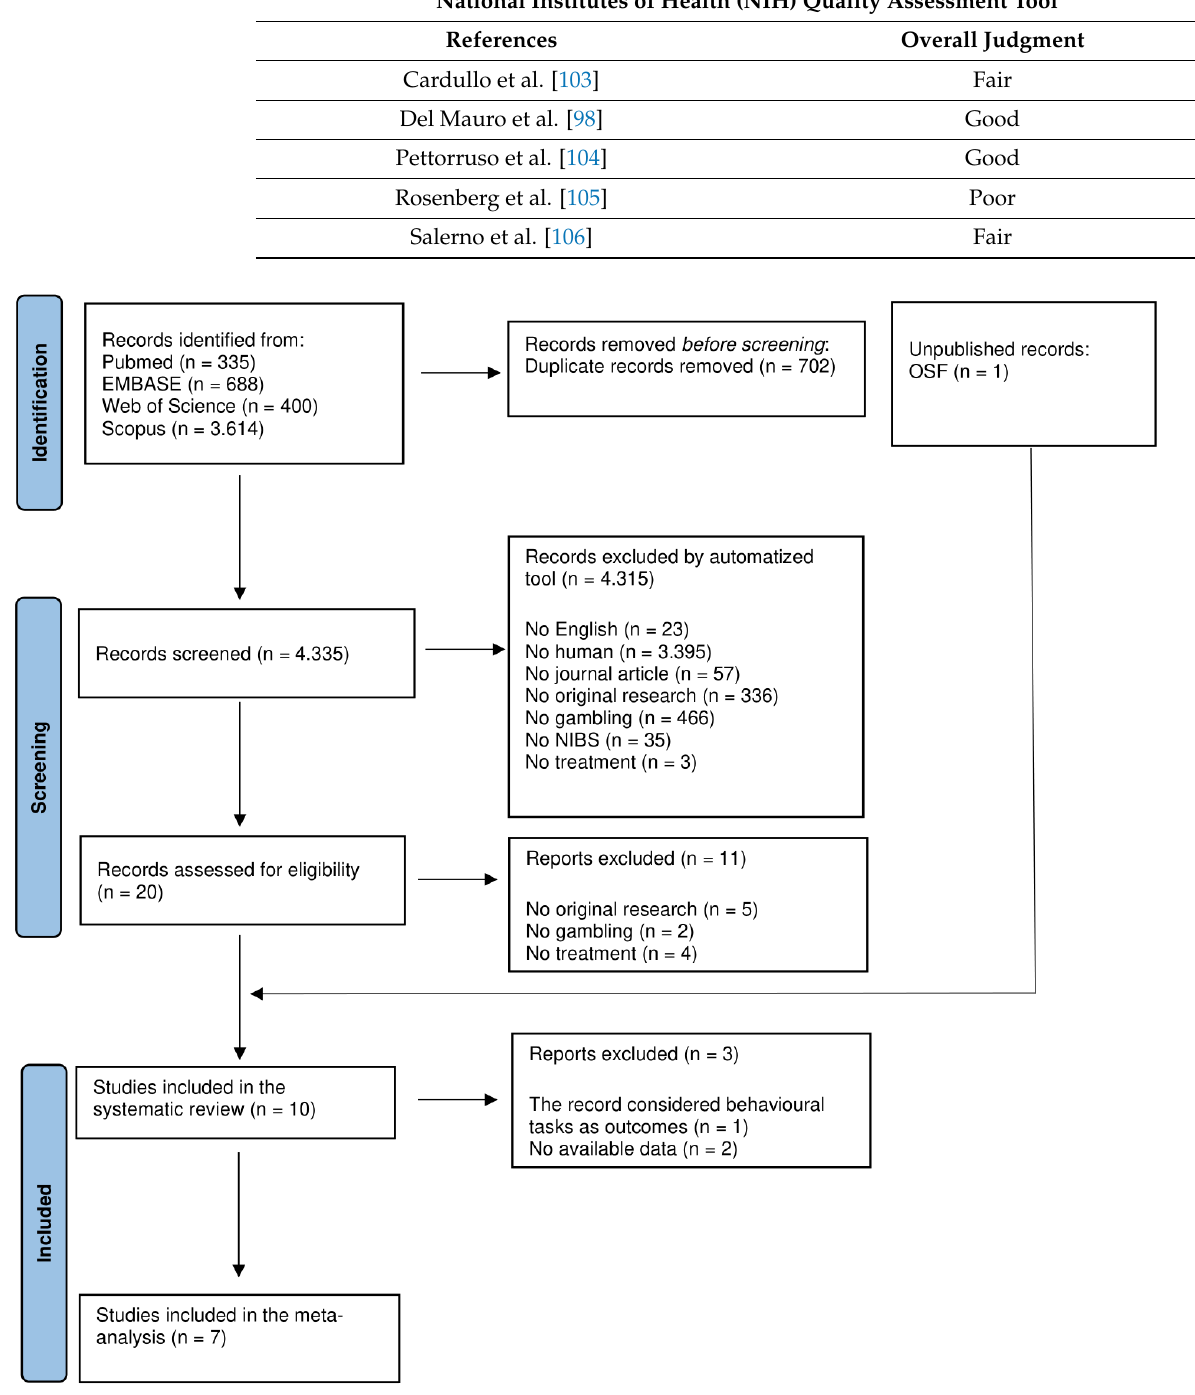
Figure 1. Flow chart of study selection. NiBS = non-invasive brain stimulation, OSF = Open Science Framework.